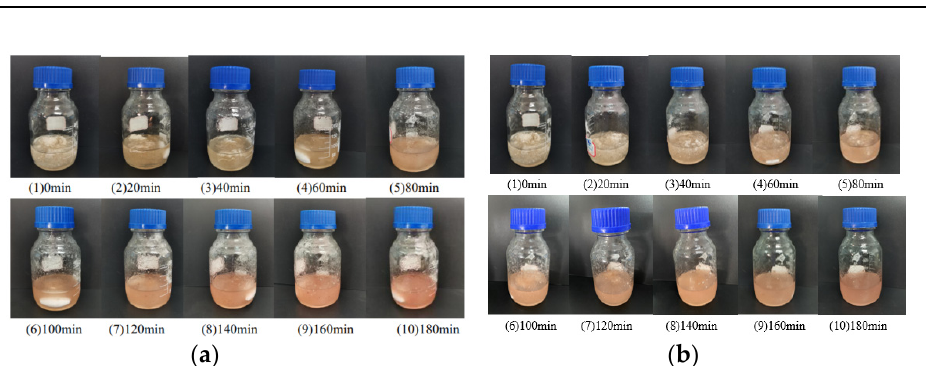
( b ) Figure 6. X-ray diffraction patterns of fibers harvested from ( a ) XM and ( b ) CM. 3.5. TG Analysis of Different Stages of Nanocellulose Treated with Deep Eutectic Solvent The TG curves of nanocellulose obtained from different stages of cotton fibers can be seen in Figure 7. This can not only reflect their thermal stability, but also reflect the differ- ence of crystallinity and molecular weight between them. All samples showed similar TG curves, and the initial degradation temperatures (T onset ) of cotton cellulose at different growth stages were slightly different. The initial degradation temperature of the original cotton fiber was approximately 300 °C, while the initial degradation temperature of the prepared nanofibrillated cellulose was raised to approximately 305 °C. Compared with original cotton cellulose, nano-granulated cellulose has a smaller size, larger specific sur- face area, and lower molecular weight, thus its thermal stability is greatly affected